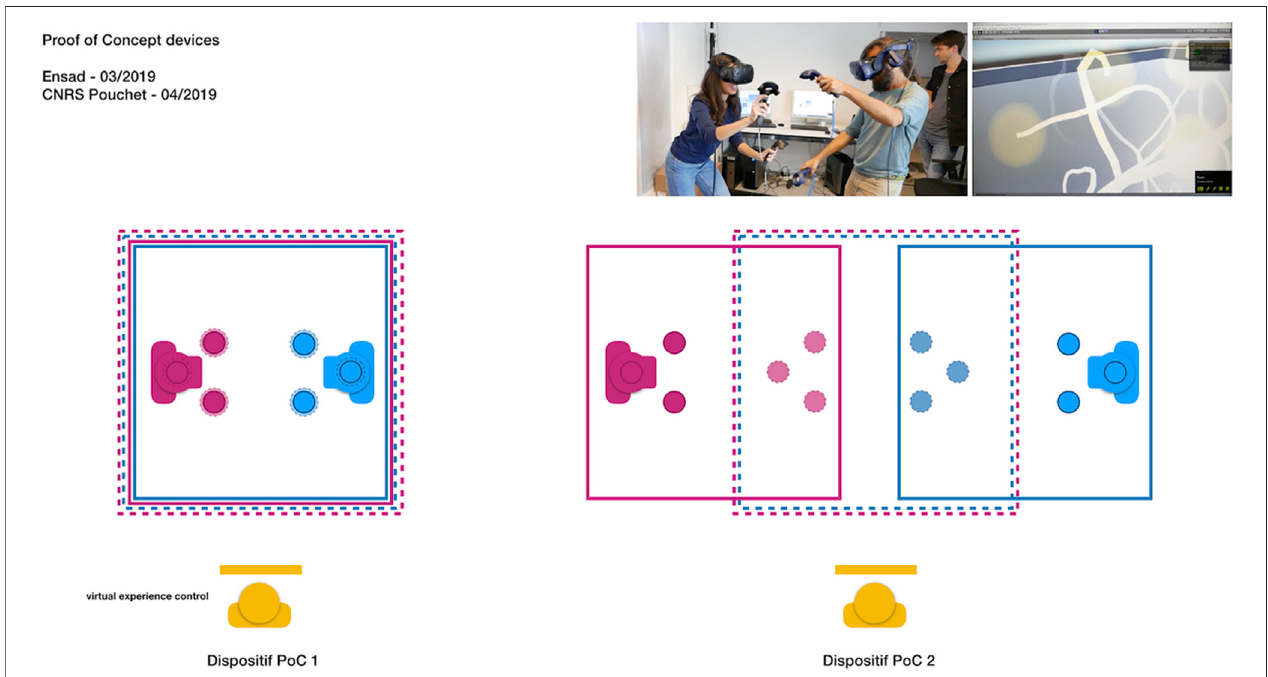
FIGURE 9 | First platform proof of concept, with shared (left) and separate (right) physical spaces.